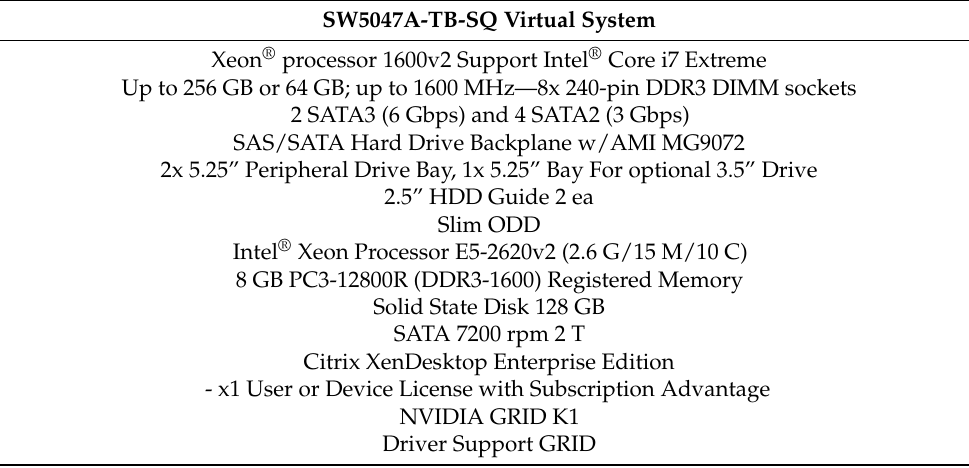
Table 15. The entire specification of VDI workstation.